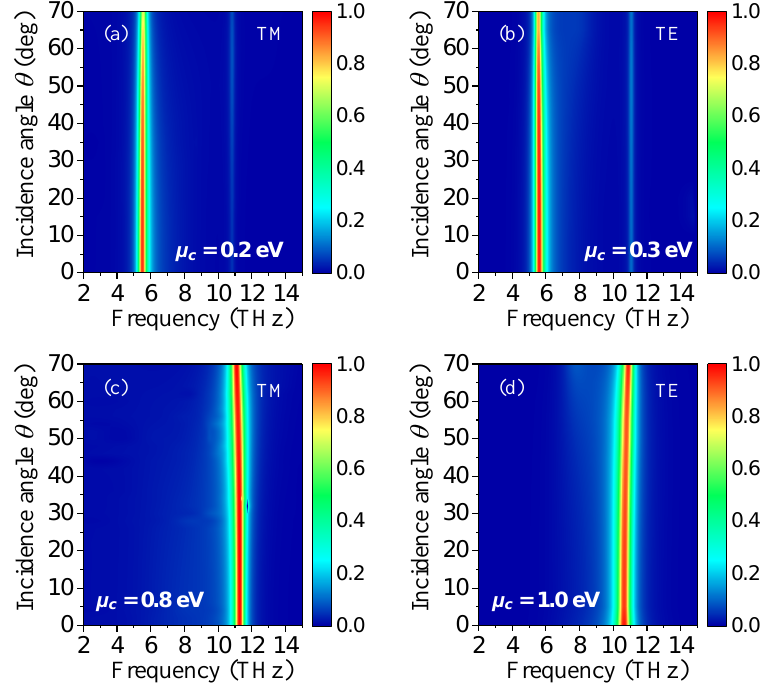
Figure 7. Simulated absorption spectra of the proposed absorber with different incident angles θ under the ( a ) TM polarization with μ c = 0.2 eV and ( b ) TE polarization with μ c = 0.3 eV. ( c ) TM polarization with μ c = 0.8 eV and ( d ) TE polarization with μ c = 1.0 eV.